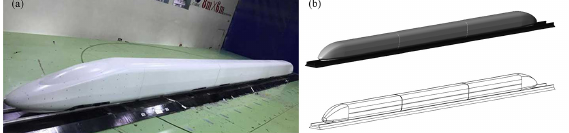
Fig. 6. Scaled train model used for algorithm verification: (a) The 1:8 scale train model in wind tunnel (b) Train model used for numerical simulations.